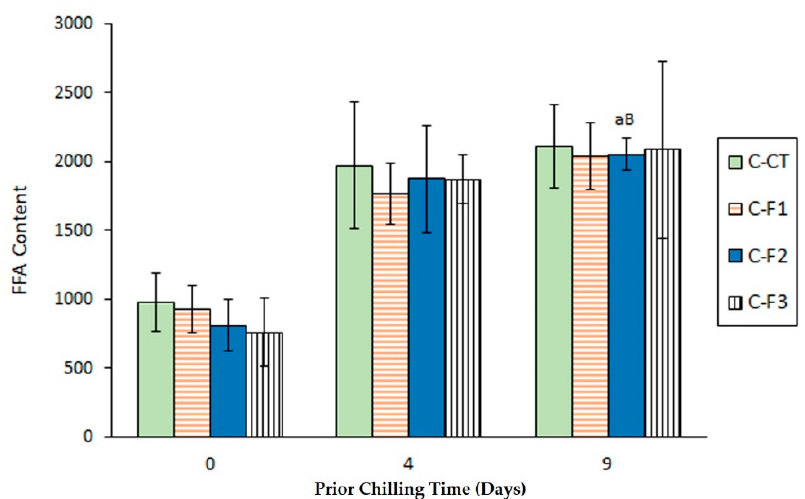
Figure 1. Assessment of free fatty acids (FFA) value (g ∙ kg − 1 muscle) in canned mackerel previously subjected to different chilling times and packaged with different alga extract concentrations. Mean values of five replicates ( n = 5). Standard deviations are indicated by bars. Initial raw fish value: 37.15 ± 11.24. For each chilling time, the same low ‐ case letter (a) denotes that no significant differences ( p > 0.05) were obtained related to the alga extract presence. For each alga extract concentration, different capital letters (A, B) denote significant differences ( p < 0.05) by effect of the chilling time. Alga extract concentrations in packaging media: C ‐ CT (control), C ‐ F1 (low alga content), C ‐ F2 (medium alga content) and C ‐ F3 (high alga content), in agreement with the Material and Methods section.